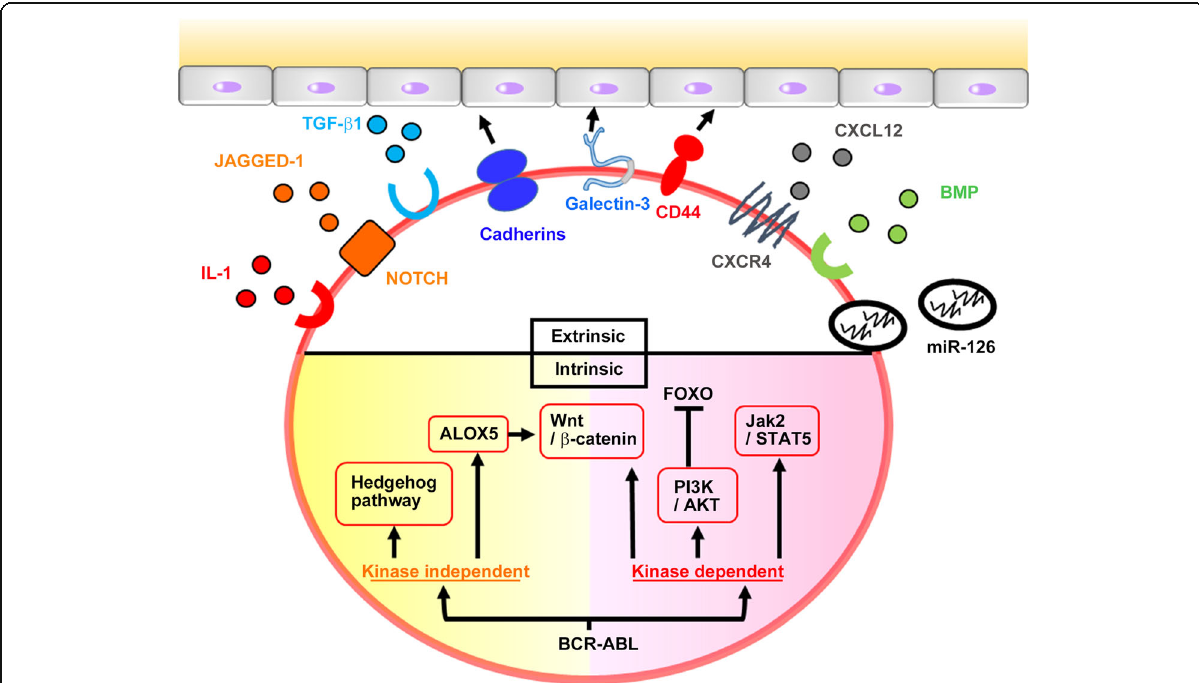
Fig. 5 Presumed mechanisms involved in CML LSC maintenance. Phosphoinositide 3-kinase (PI3K)/Akt/FOXO axis [89], Wnt signaling [90, 91], and janus kinase (JAK)2/ signal transducer and activator of transcription (STAT)5 signaling [92], are directly activated by kinase activity of BCR-ABL and sustain LSC survival. Moreover, activation of Hedgehog signaling [93] and ALOX5 [94] can maintain LSC survival independently of BCR-ABL kinase activity. LSC survival further requires their localization to bone marrow niche with the help of several LSC-expressing adhesion molecules such as cadherins [95], CD44 [96], and galectin-3 [97]. Furthermore, bone marrow resident cells secrete various mediators including Jagged 1 (a NOTCH ligand) [98], transforming growth factor (TGF)- β 1 [99], bone morphogenic proteins (BMPs) [100], a chemokine, CXCL12 [101], interleukin